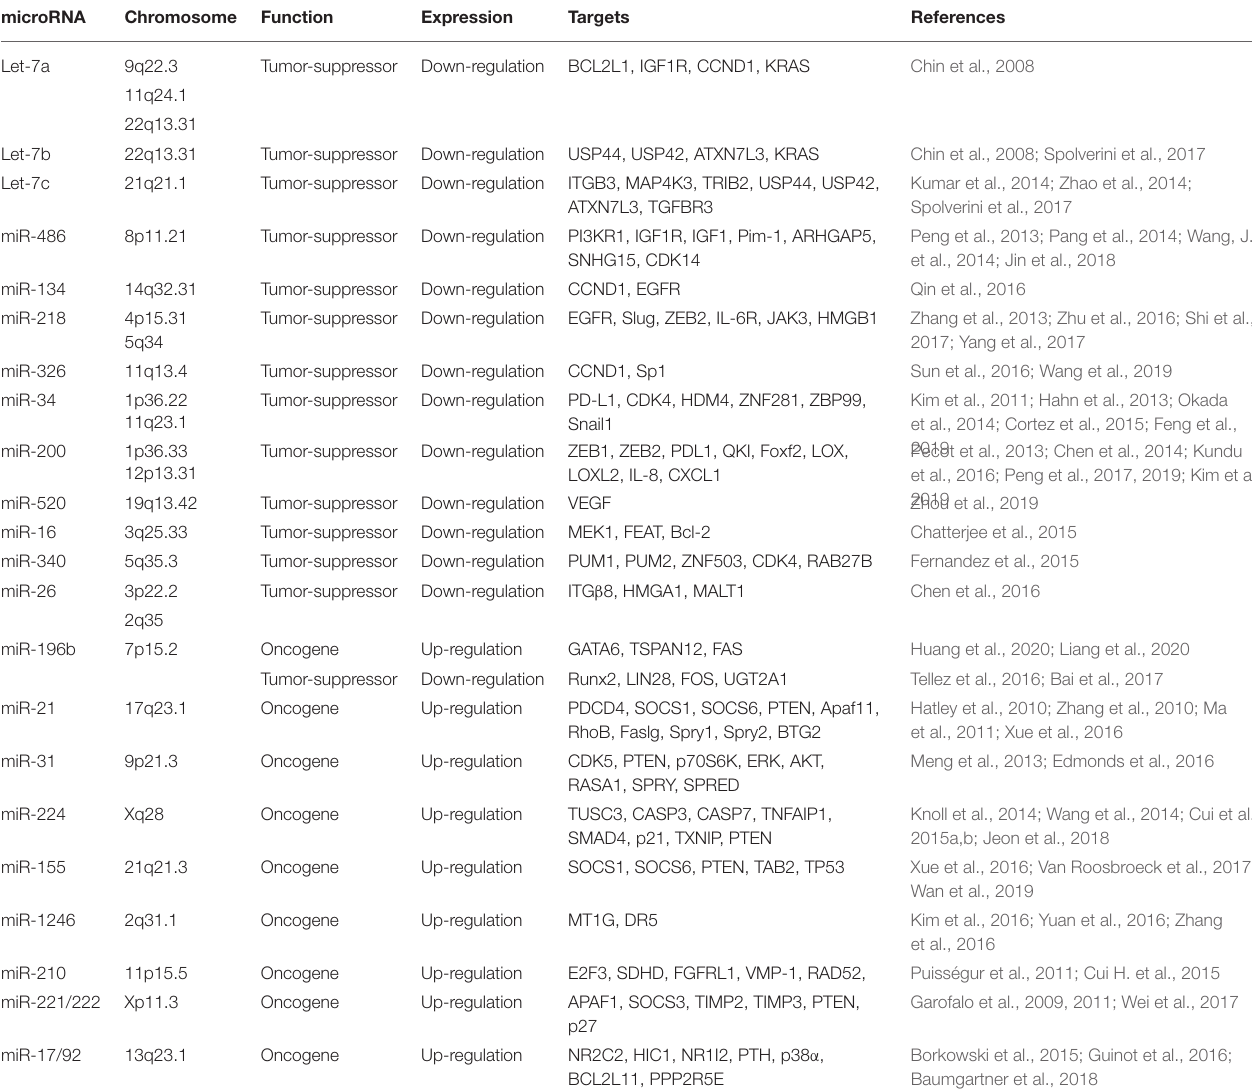
TABLE 1 | Representative oncogenic or tumor suppressive miRNAs in NSCLC.